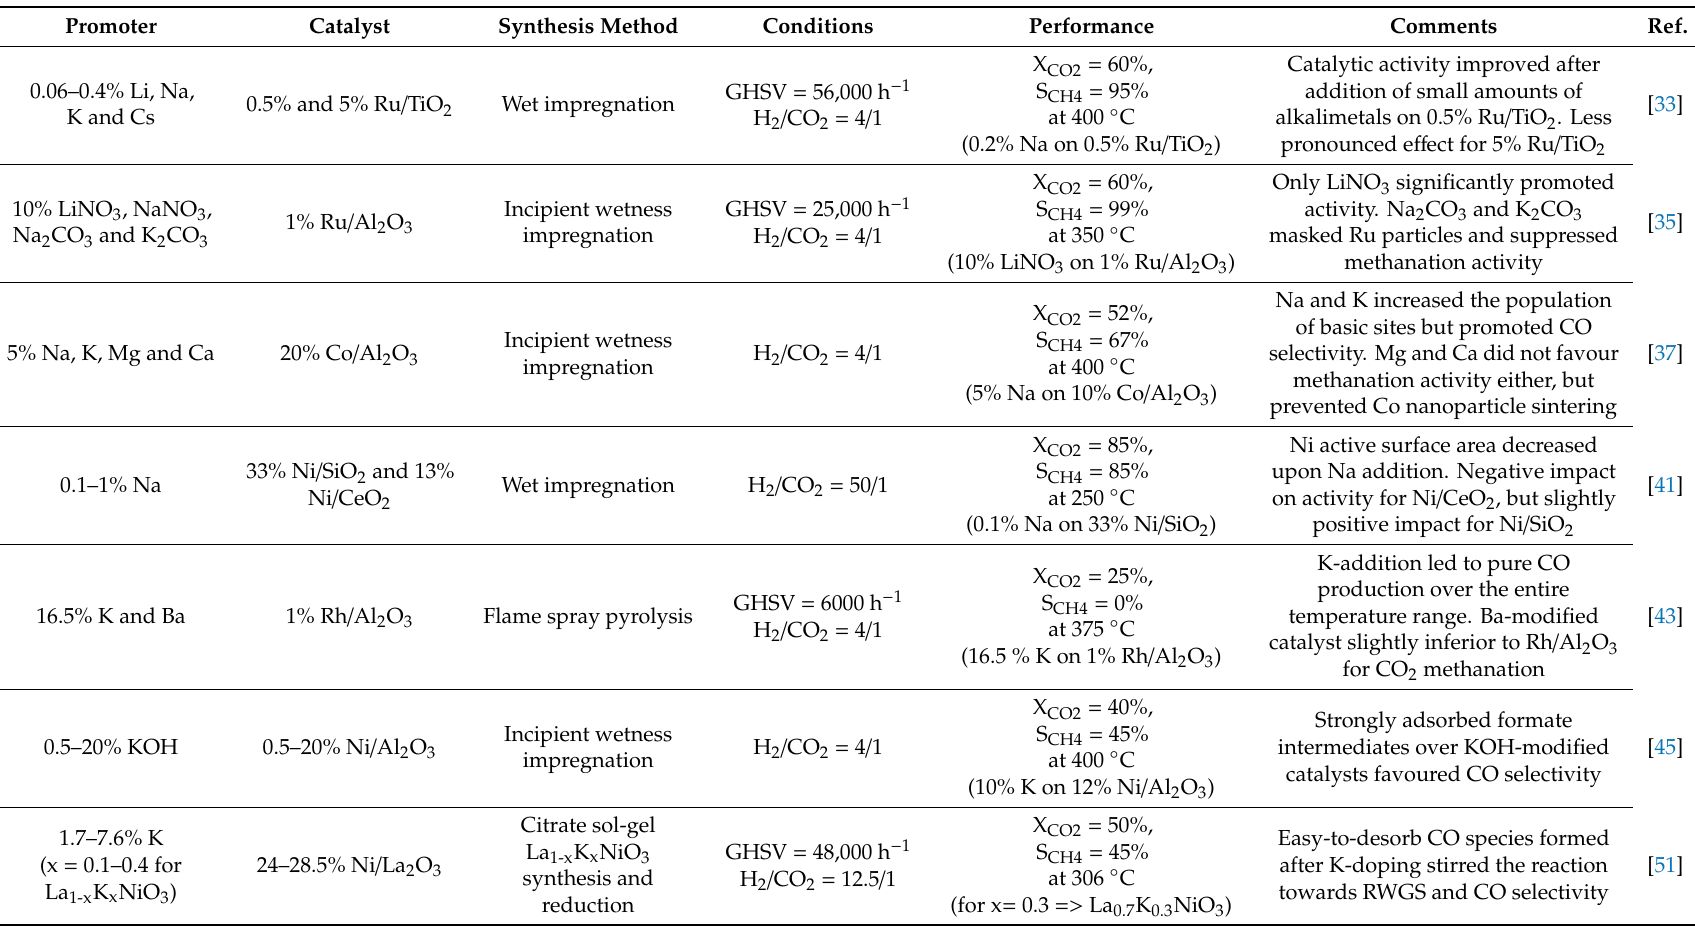
Table 1. Summary of some typical alkali and alkaline earth promoted catalysts on the methanation of CO 2